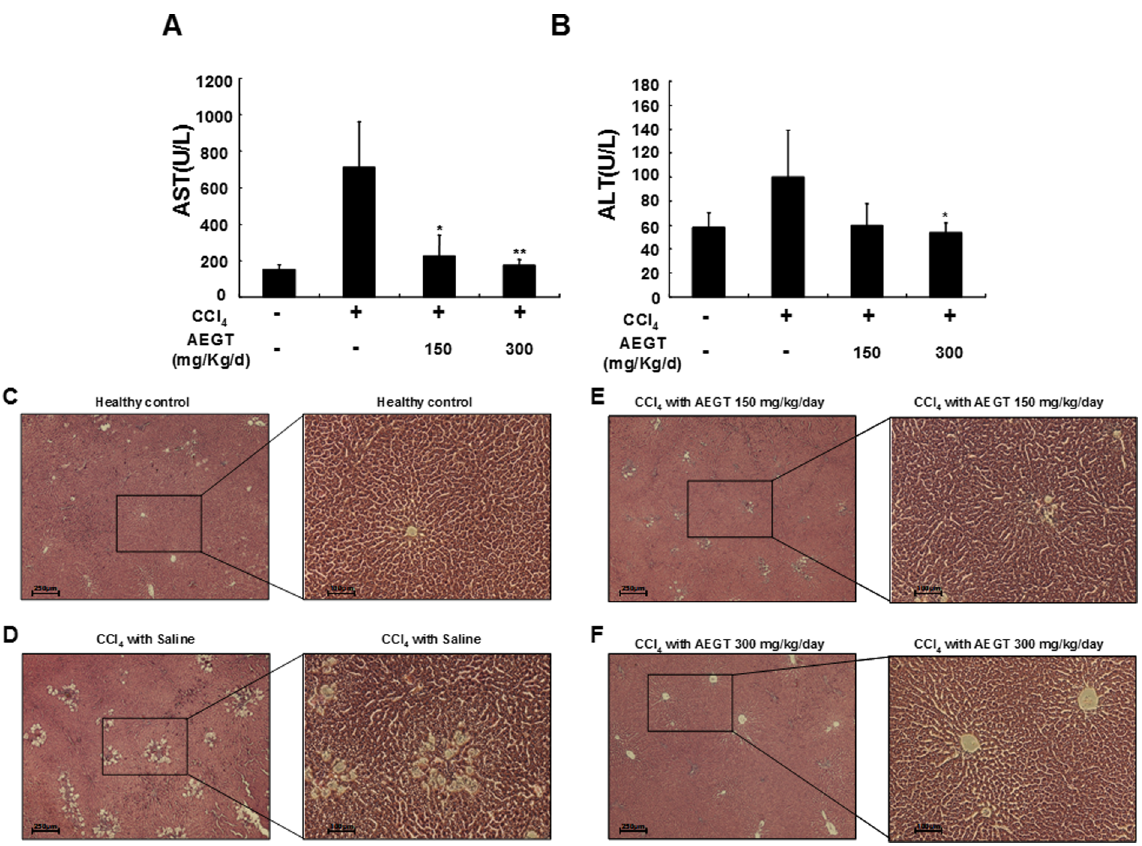
Figure 7. Effect of AEGT on CCl4-induced acute liver injury in Wistar rat. The Wistar rats were given the indicated doses of AEGT for 3 days and then administered CCl4 for 1 day. The rats were sacrificed to collect blood samples and liver sections for biochemical parameter analysis of (A) AST and (B) ALT and histopathological examination [(C) Healthy control, (D) CCl4 with saline, (E) CCl4 with 150 mg/kg/day AEGT, and (F) CCl4 with 300 mg/kg/day AEGT]. Values are presented as the means of five independent experiments. Error bars indicate the means 6 SD of three independent experiments. * P , 0.05; ** P , 0.01.